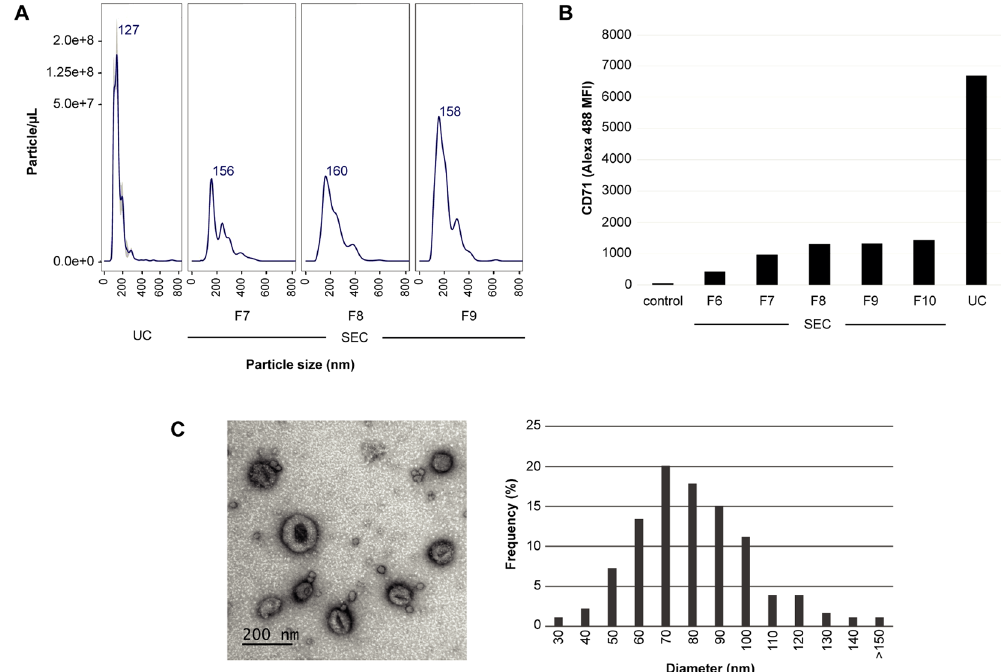
Figure 1. Isolation and characterization of exosomes derived from human cord blood reticulocytes. ( A ) NTA profiles of HuRex from ultracentrifugation (UC) and size exclusion chromatography (SEC) fractions. Concentration is shown in particle/ µ L. (B) Flow cytometry analysis of transferrin receptor, CD71, in HuRex . MFI, Median Fluorescence Intensity. (C) Electron microscopy. Representative TEM image on the left. Bar represents 200 nm. Size distribution from TEM images quantified by ImageJ on the right. nm,